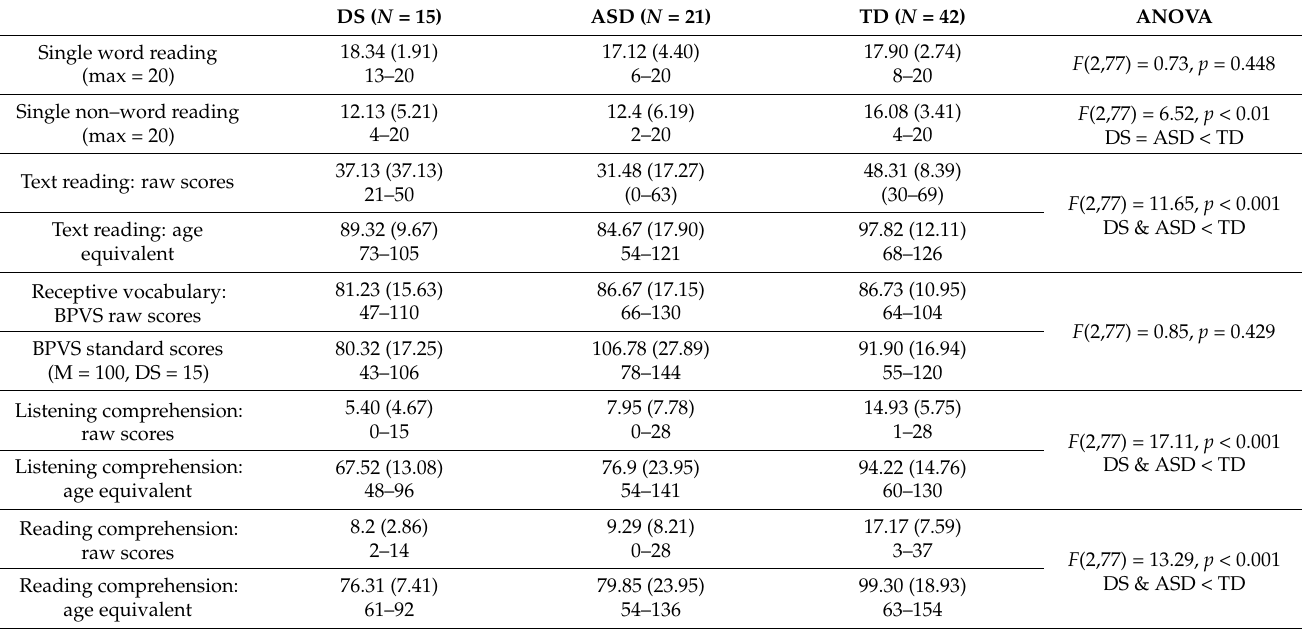
Table 1. Descriptive statistics for all measures (raw and standard scores are reported where